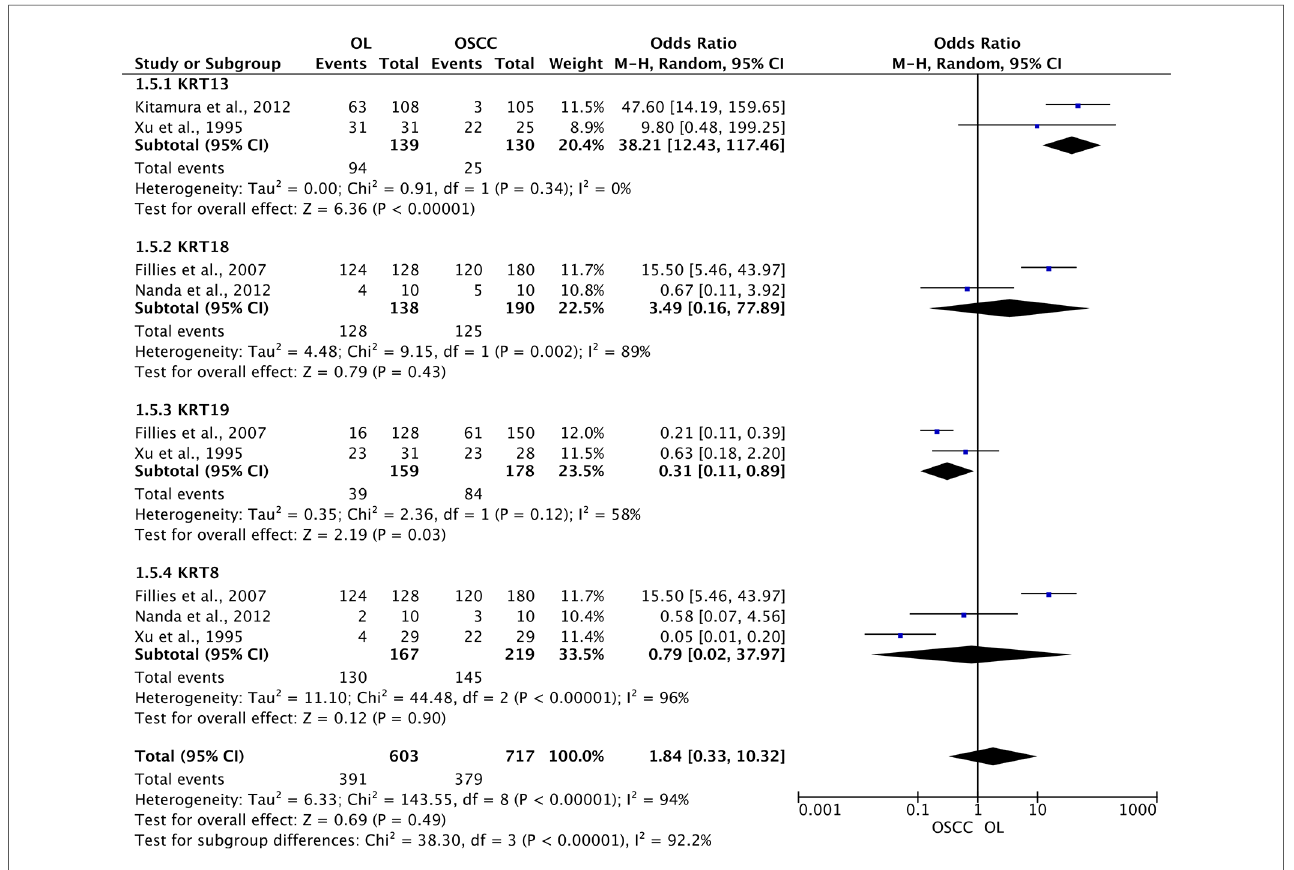
FIGURE 7 Association of expression of cytokeratins in oral leukoplakia (OL) compared to oral squamous cell carcinoma